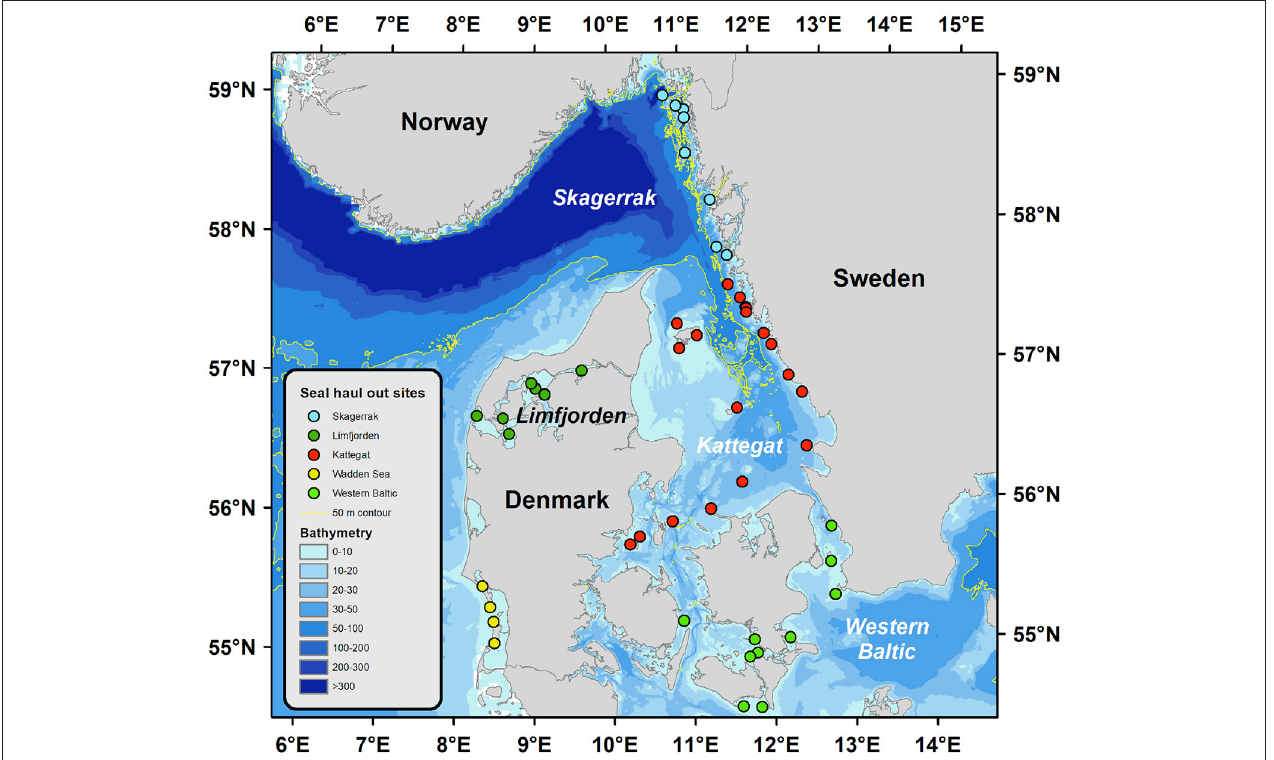
FIGURE 1 | Geographical locations of the harbor seal populations indicated by circles in different colors. Bathymetry is dramatically different for the different regions, which imply smaller areas of suitable feeding grounds (1–50m) for young seals in Skagerrak and Limfjorden compared to Kattegat and Western Baltic which could partly explain the reduction in somatic growth with increasing population size observed in Limfjorden and Skagerrak. The Wadden sea population was not included in the current